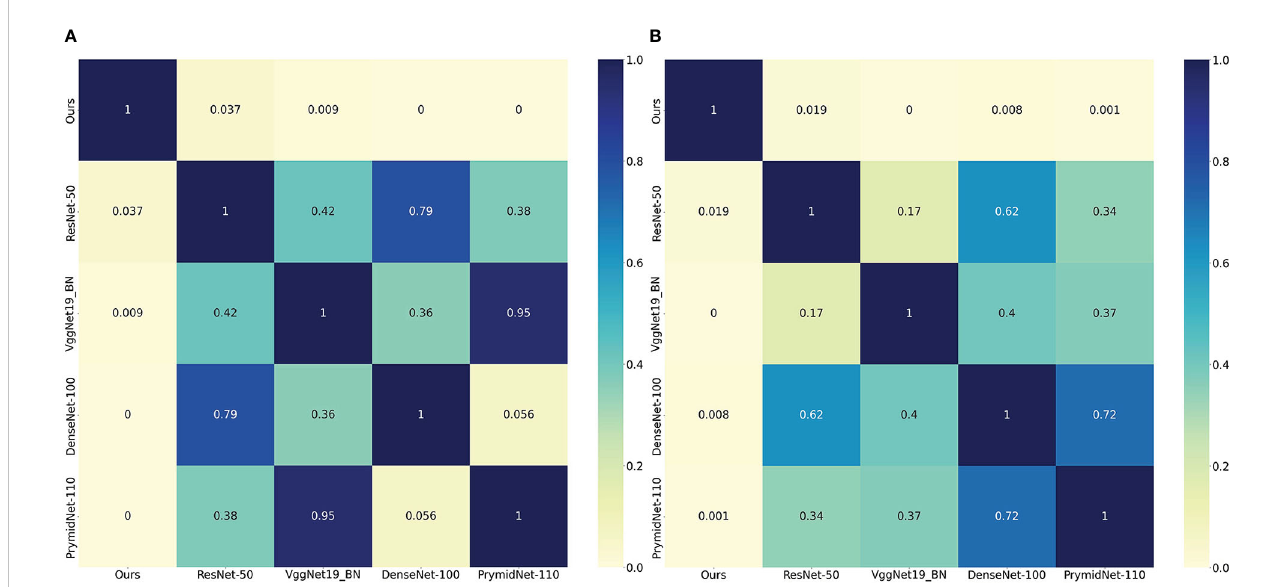
FIGURE 5 Heat map of the signi fi cance t-test, the values in each square of the heat map represent the corresponding p-values between two DL models, and two statistical variables were considered statistically signi fi cant when the p-value was less than 0.05. All statistical tests were performed on the predicted results of the validation cohort. The left heat map represents the corresponding p-values of PD-1 expression and the right represents PD-L1 expression. We set the value in each square to zero if the corresponding p-value is less than 0.001. (A) denotes PD-1 expression and (B) denotes PD-L1